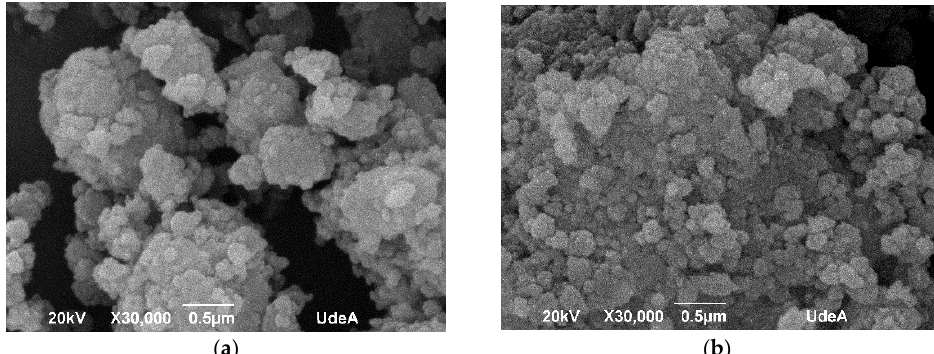
Figure 4. Scanning electron microscopy images of ( a ) AlNi1 and ( b ) AlNi1Pd1.